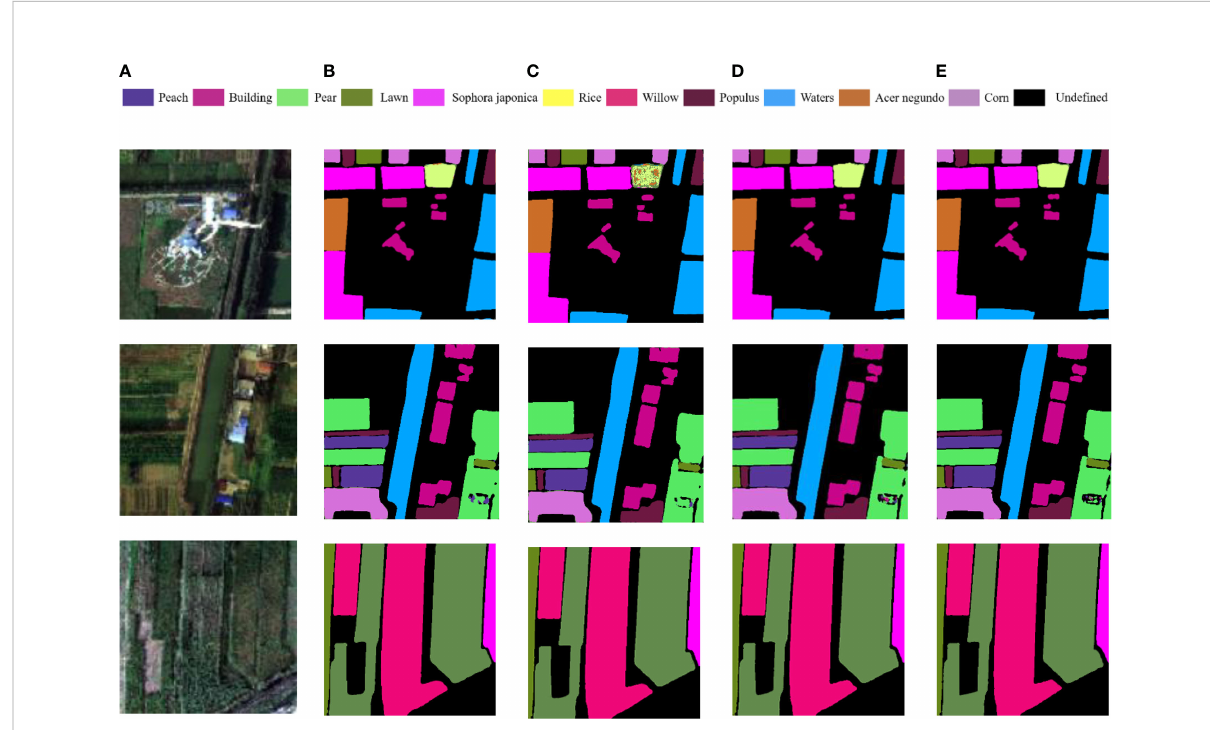
FIGURE 12 Comparison of experimental results of different data features superposition methods: (A) Test set; (B) PCA; (C) PCA+NDVI; (D) PCA+NDVI +GLCM; (E)